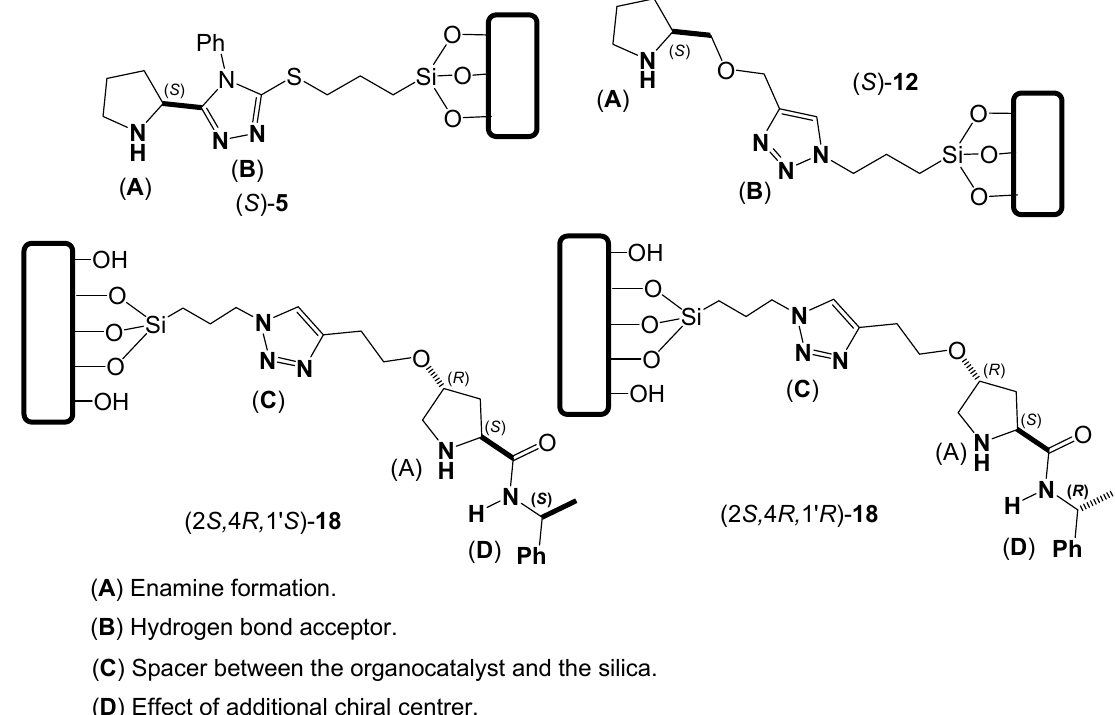
Figure 1. Novel silica-supported organocatalysts synthesized in this work.